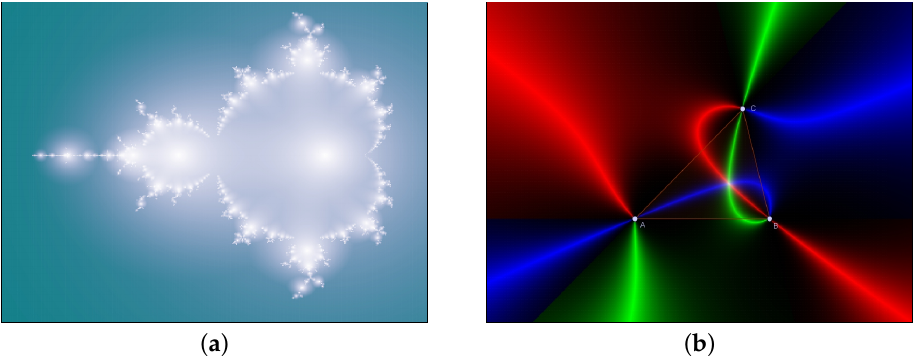
Figure 8. ( a ) The classic Mandelbrot set, created with the dynamic color scanning method. ( b ) An application to investigate the Fermat point of an arbitrary